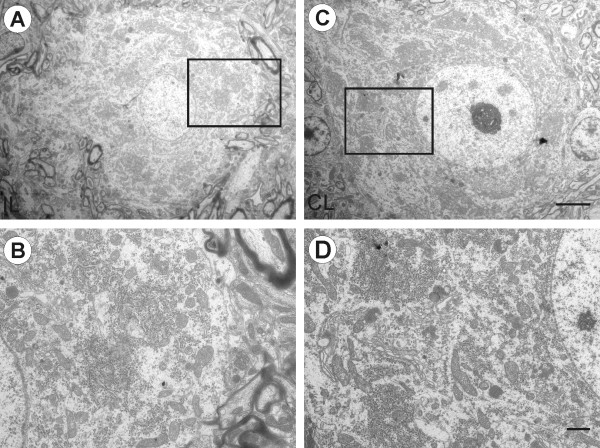
Electron photomicrographs of spinal cord motoneurons of C57BL/6J mice. (A) One α-motoneuron found on the ipsilateral side. The boxed area is shown at higher magnification in (B). Some synaptic terminals are retracted; the cytoplasm and nuclei have a normal appearance. (C) contralateral α-motoneuron. (D) Higher magnification shows cytoplasmatic organelles visible and well organized rough endoplasmic reticulum (RER), Golgi apparatus (GA) and mitochondria. Scale bar: 5 μm (A and C), 1 μm (B-D).